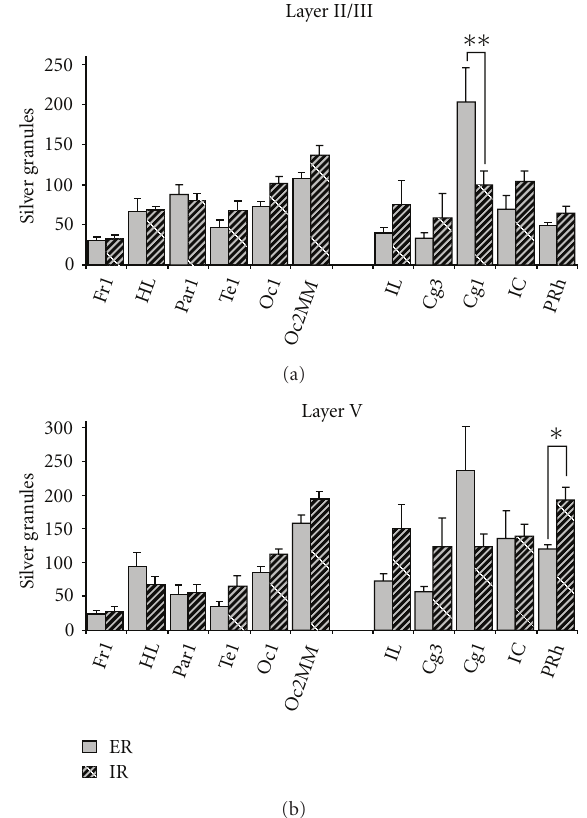
Figure 5: Comparison between silver granule densities of enriched- (ER, uni) and impoverished-reared (IR, striped) gerbils in layer II/III (a) and layer V (b) of motor (Fr1, HL), sensory (Par1, Te1, Oc1, Oc2MM), and prefronto-limbic areas (IL, Cg3, Cg1, IC, PRh). Note higher density values of Cg1 in ER-animals and higher values of PRh in IR-animals. Data are given as mean + standard error. Asterisks indicate levels of significance according to posthoc analysis of variance (ANOVA) testings. ∗ : P < . 05, ∗∗ : P < . 01. For abbreviations see legend to Figure